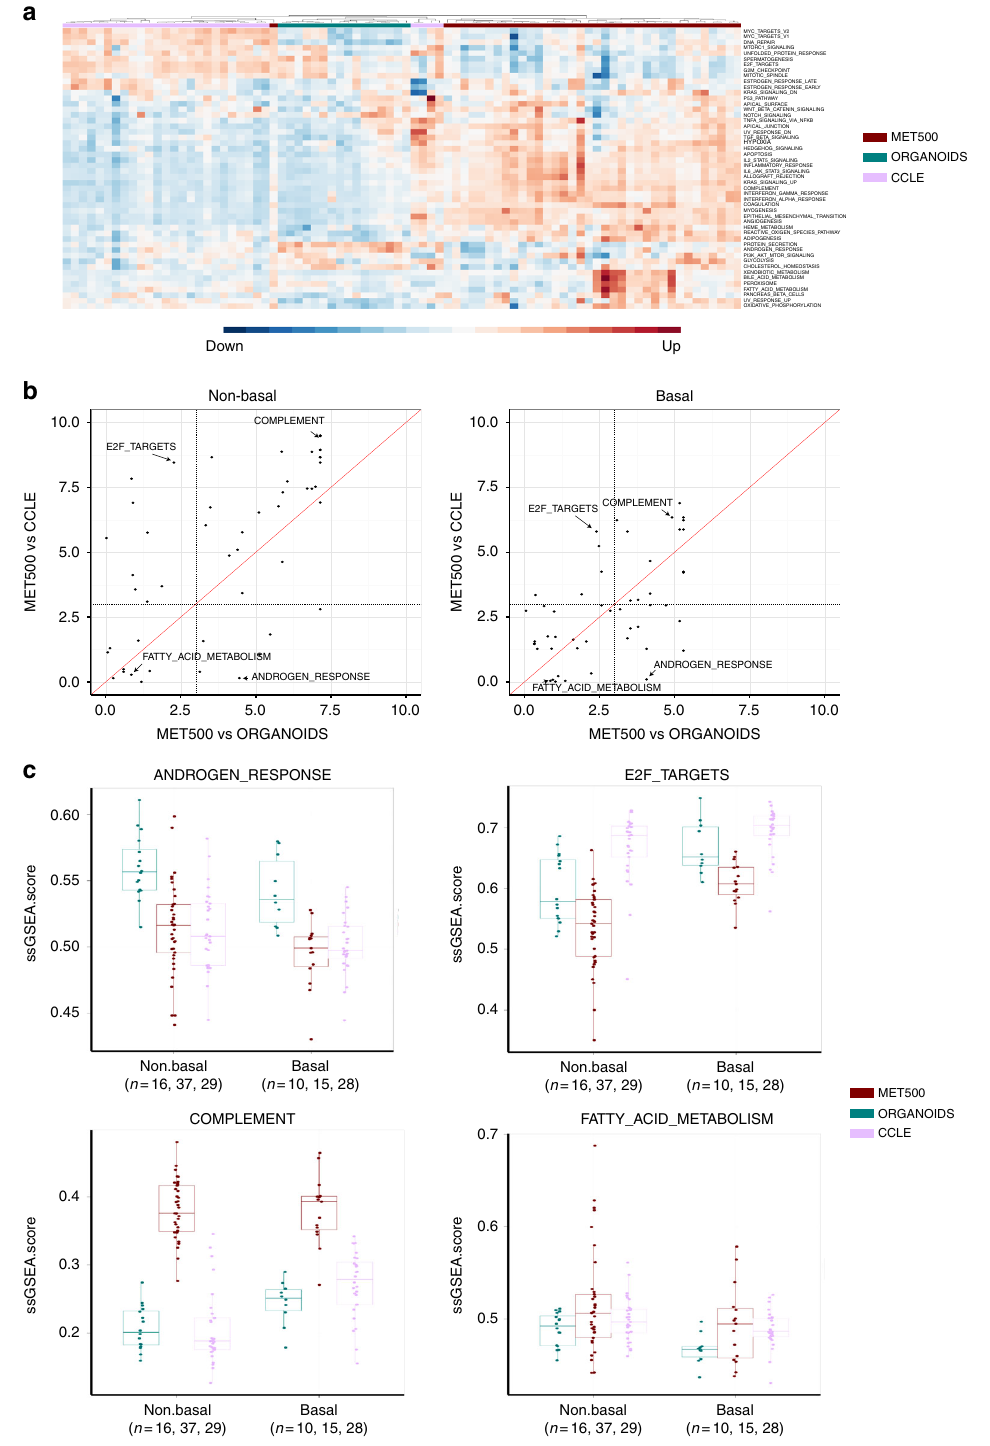
Fig. 6 Comparison of ssGSEA scores of the 50 MSigDB hallmark gene sets. a Visualization of ssGSEA scores across non-Basal-like CCLE breast cancer cell lines, MET500 breast cancer samples, and organoids. b DA analysis results of different breast cancer subtypes. Each dot is a hallmark gene set, with the x - axis representing − log10(FDR) derived from MET500-vs-organoids comparison, and the y -axis representing − log10(FDR) derived from MET500-vs-CCLE comparison. c Boxplot of ssGSEA scores of the four representative gene sets. In each box, the central line represents the median value and the bounds represent the 25th and 75th percentiles (interquartile range). The whiskers encompass 1.5 times the interquartile range. Source data are provided as a Source Data fi